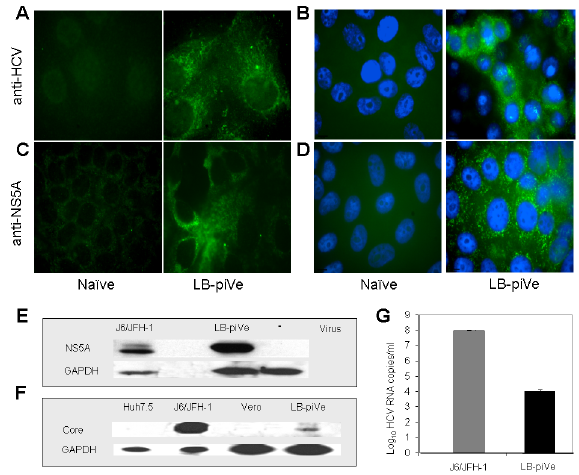
Figure 1. Genotype 1b-persistently infected VeroE6 cells express HCV antigens. Immunostaining of naı¨ve VeroE6 (A–D, left panels ) and LB-piVe cells (A–D, right panels ). LB-piVe cells (A, C) and LB- piVe-enriched, panned cells (B, D). (E, F) Immunoblot of LB-piVe and J6/ JFH-1-infected cell extracts, stained with anti-NS5A antibody (E) or anti- Core antibody (F). (G) HCV RNA extracted from filter-clarified supernatants from J6/JFH-1-infected Huh7.5 and VA RNA I -transfected LB-piVe cells, quantitated by real-time PCR. Error bars, 6 SD.